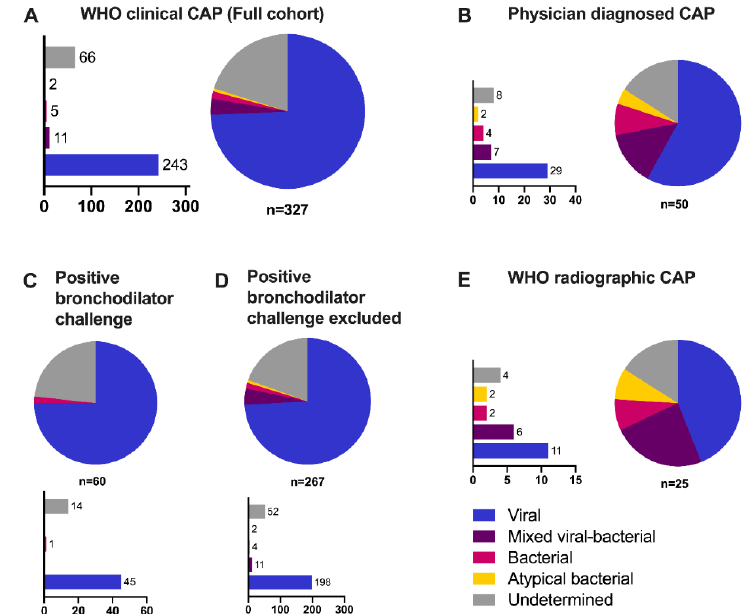
Figure 3. Etiology classification of children with clinical CAP in the TREND study in ( A ) the full cohort based on WHO criteria (n = 327), ( B ) children with physician-diagnosed CAP (ICD-10 code of J10.0, J11.0 or J12-J18) (n = 50), children ( C ) with (n = 60) or ( D ) without (n = 267) positive bronchodilator challenge and ( E ) children with WHO radiographic CAP (n = 25). Abbreviations: CAP, community-acquired pneumonia; WHO, World Health